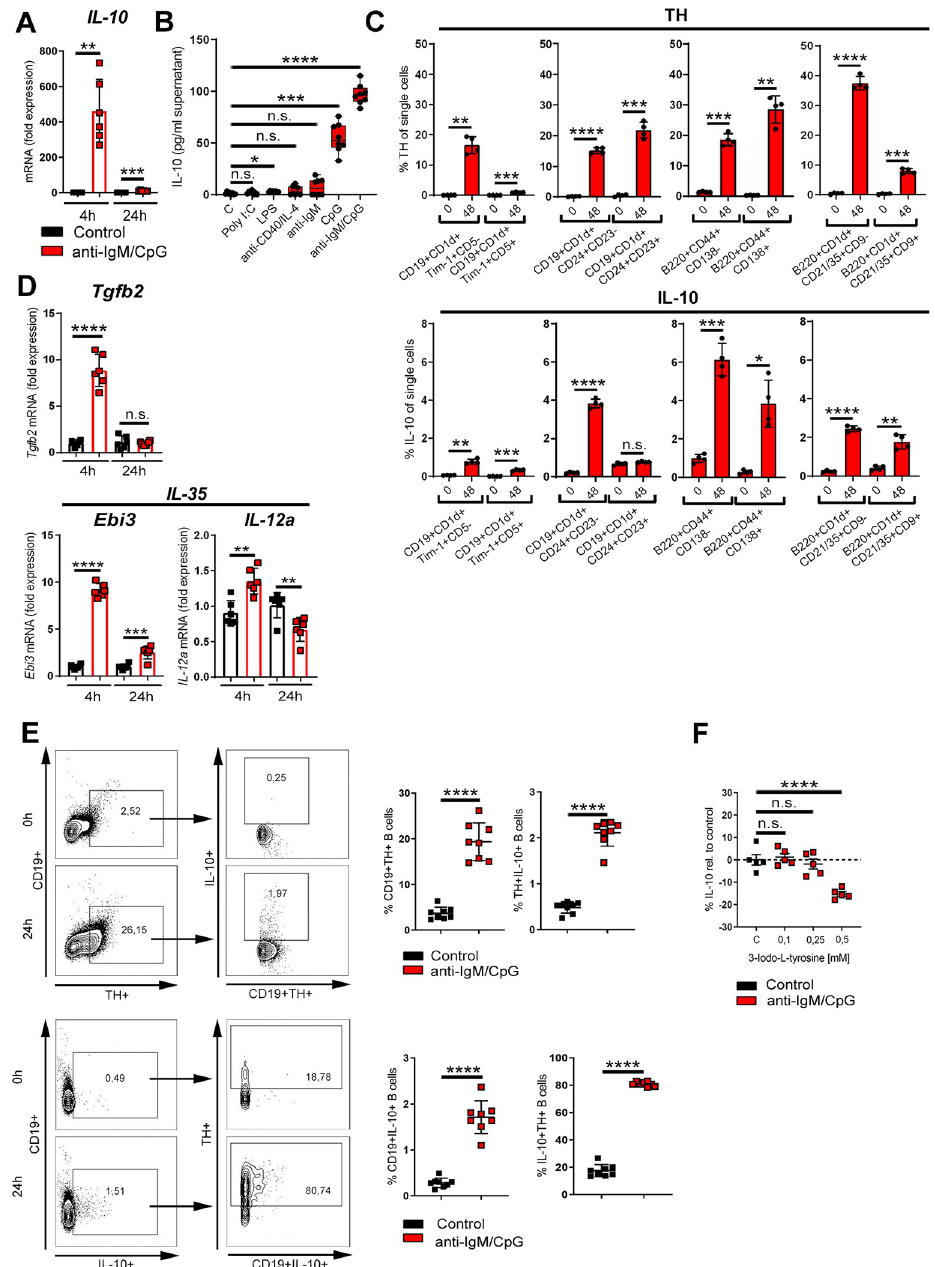
Fig 5. TH up-regulation is associated with IL-10 production. ( A ) B cells were activated for 4 h and 24 h with anti- IgM/CpG or left nonactivated. The expression of IL-10 was determined by qRT-PCR ( n = 6). ( B ) B cells were activated with indicated TD or TI stimuli (anti-CD40; Poly I:C, LPS, CpG: 1.25 μ g/mL; anti-IgM: 5 μ g/mL; IL-4: 1.25ng/mL). Nonactivated B cells were used as controls. The production of IL-10 was measured in the cell culture supernatant by ELISA ( n = 8). ( C ) B cells were activated with anti-IgM/CpG or left untreated. After 48 h, Breg populations and their TH and IL-10 expression were analyzed by flow cytometry and compared to control B cells (0 h) ( n = 4). The gating strategy of indicated Breg populations with their characteristic surface markers is available in S8 and S9 Figs. ( D ) Anti- IgM/CpG-activated B cells or nonactivated cells were cultivated for 4 h or 24 h. The expression of indicated genes was determined by qRT-PCR ( n = 6). ( E ) B cells were activated with anti-IgM/CpG for 24 h or left nonactivated. The expression of CD19+TH+, CD19+IL-10+, TH+IL-10+, and IL10+TH+ B cells was analyzed by flow cytometry ( n = 8). One representative dot plot is shown. ( F ) B cells were treated with different concentrations of the TH inhibitor 3-Iodo- L-tyrosine for 30 min, before activation with anti-IgM/CpG. The production of IL-10 was analyzed in cell supernatants by ELISA ( n = 5). B cells from naive DBA/1J mice were used for the experiments. Data are pooled from 3 (E) or 4 (B)